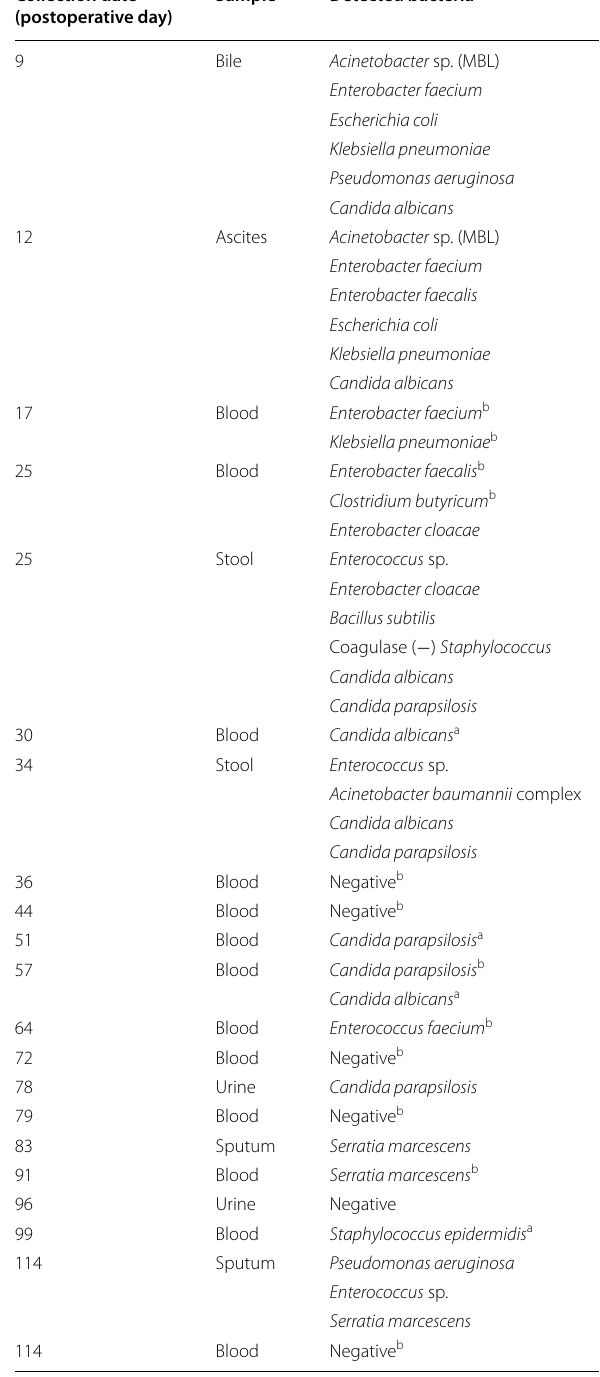
Table 3 Postoperative culture test of case